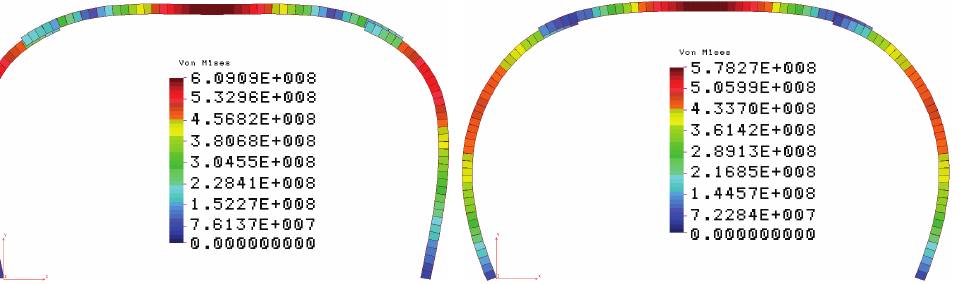
Figure 9: The map of reduced stresses in the A (left) and B and C (right) frames for load scheme II ( q deformation scale 10×).